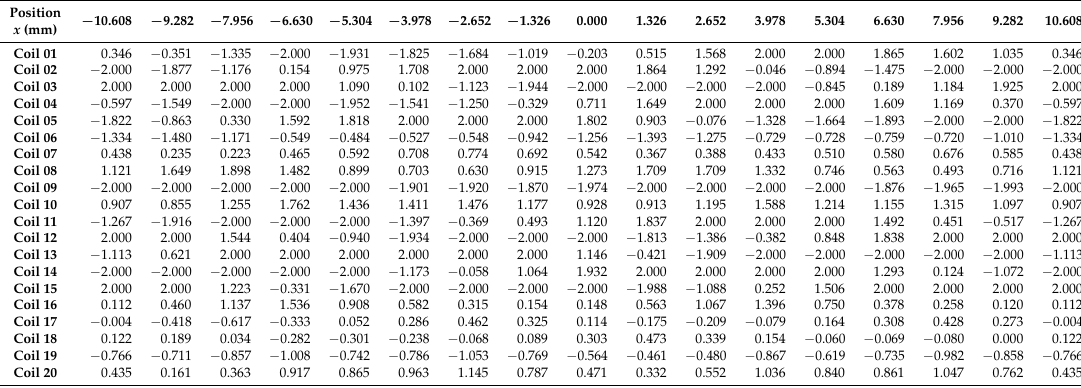
Figure 13. One point measured data: ( a ) Electromagnetic forces F x , F y , and F z ; ( b ) electromagnetic torques T x , T y , and T z . Table 2. Coil currents solved by the convex quadratic optimization commutation method when the desired electromagnetic forces and torques are W d = ( F x d , F y d , F z d , T x d , T y d , T z d ) T = (10N, 0, 10N, 0, 0, 0) T , supposing the air gap z = 1 mm and the coil array stage, respectively, located in 17 positions in the x -direction, ranging from − 10.61 mm to 10.61 mm ( y = 10.61 mm).